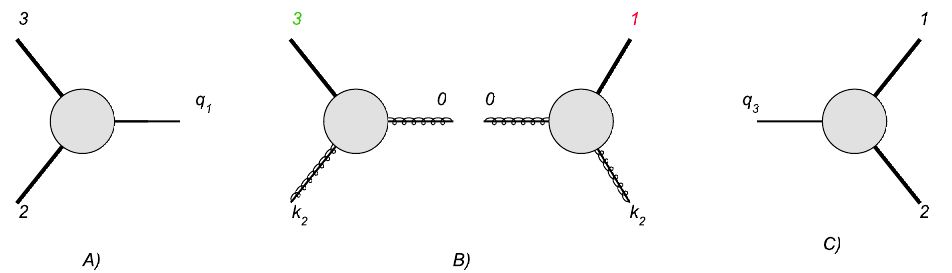
( g ∗ , g ∗ , g ∗ ) for shift of the k 1 and k 3 0+3 1 2 3